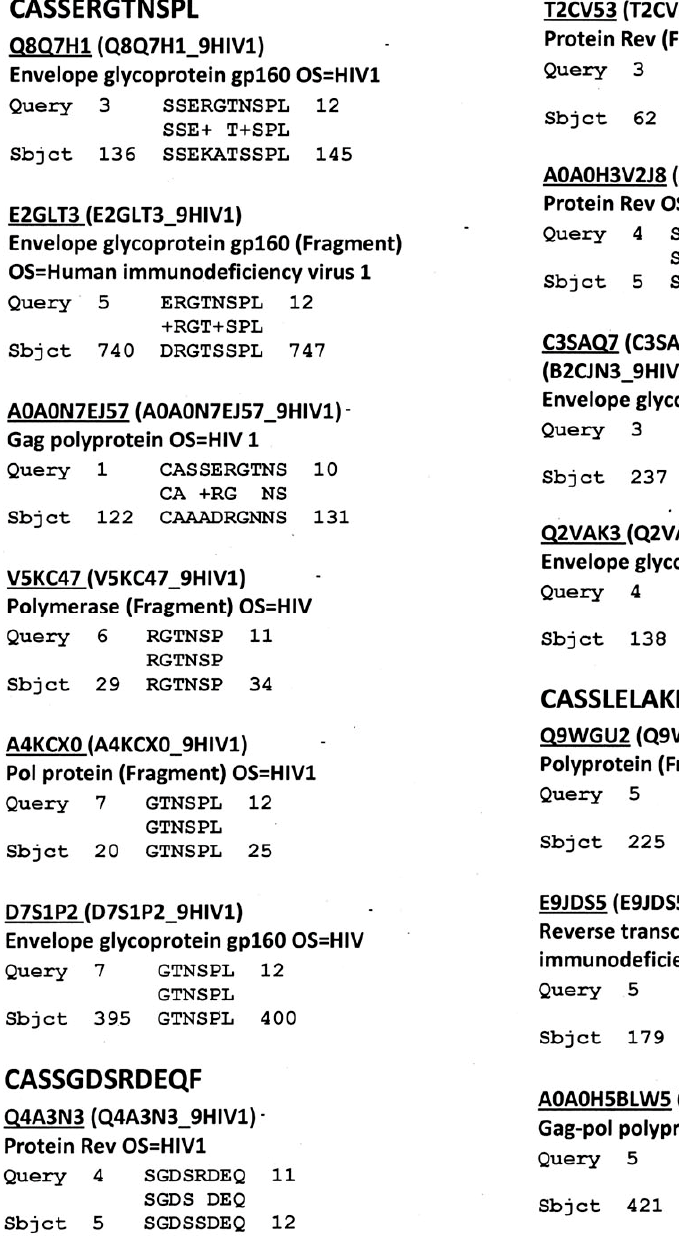
Figure 2. Typical selection of HIV TCR-HIV protein similarities (BLAST 2.0 search, virus database, E = 1000, no gaps). Accession numbers are for the UniProt protein database (www.expasy.org). See Table 3 for aggregate data for all 600 TCR examined.